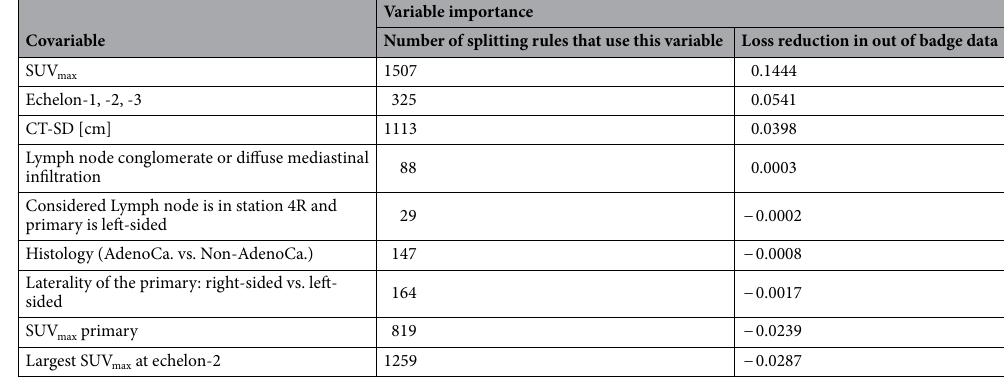
Table 3. Random forest model for prediction of EBUS-positivity. CT-SD CT short-axis diameter of the lymph node. Model was adapted to the whole dataset.